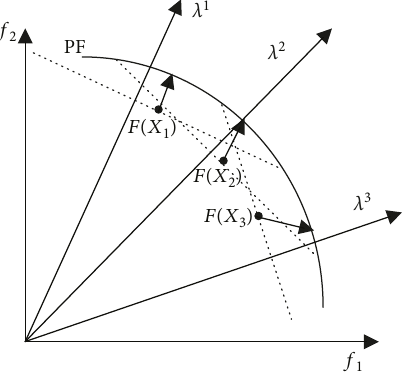
Figure 1: Solution generation process of MOEA/D.